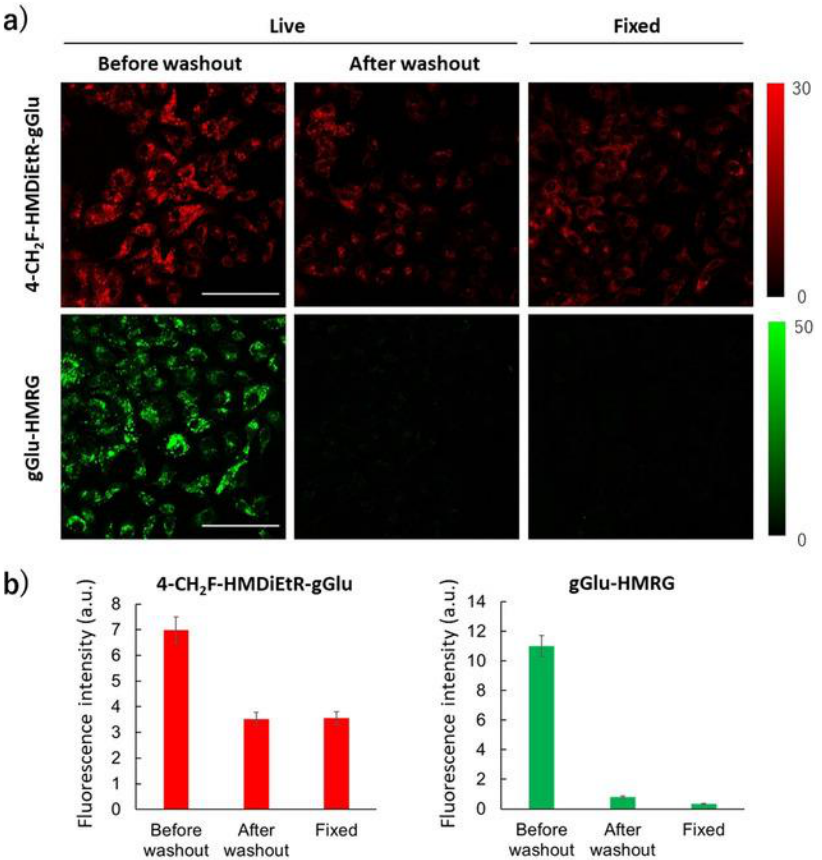
Figure 16. ( a ) Fluorescent imaging of γ -glutamyl transpeptidase activity in SHIN3 cells with 4-CH 2 F-HMDiEtR-gGlu and non-immobilizable gGlu-HMRG (1 µM) before washing, after washing, and after fixation with 4% paraformaldehyde. ( b ) The measured fluorescent intensity. Reproduced with permission from [70], copyright 2020 John Wiley and Sons.